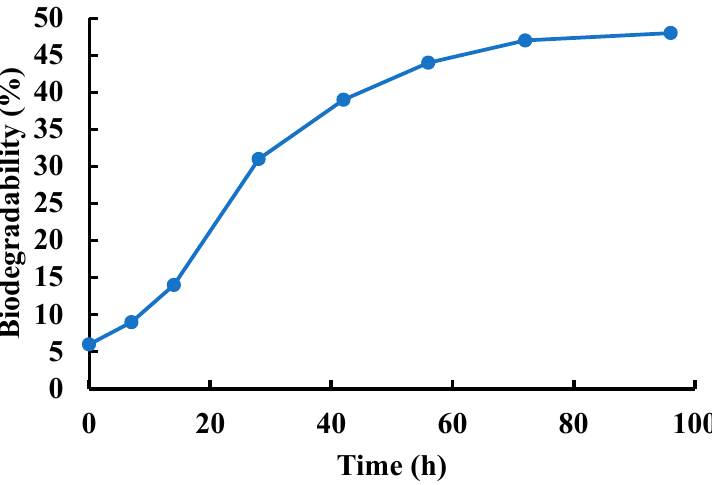
Figure 6. The degradation rate of optimized PVA/GO-Ag-CUR nanofiber in pH 7.4 at 37 °C.